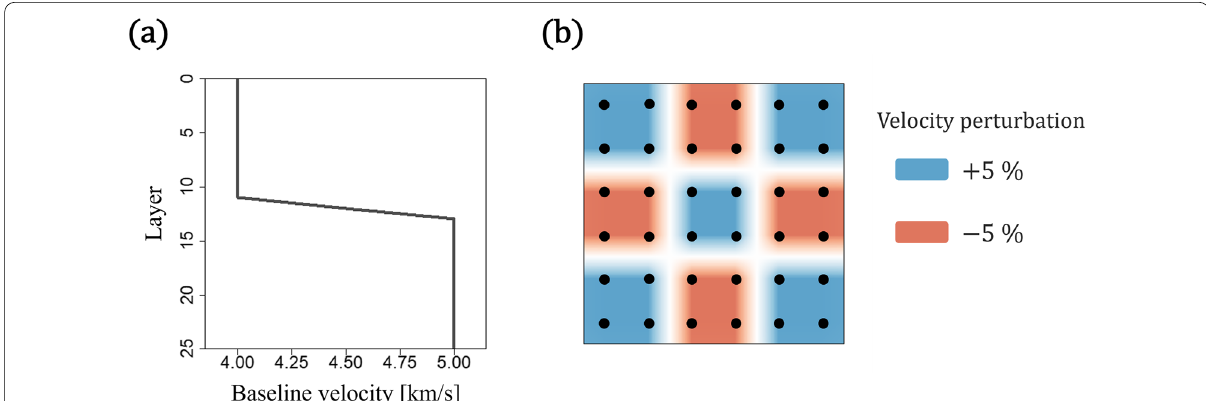
Fig. 3 a Baseline velocity–depth profile for the 26-layer model: 4.0 km/s in Layers 0–11, 4.5 km/s in Layer 12, and 5.0 km/s in Layers 13–25. b Introduced velocity anomalies of the true velocity structure from the baseline velocity in each layer. Dots represent grid point locations. Blue and red indicate that the estimated velocities are faster and slower than the baseline velocity, respectively